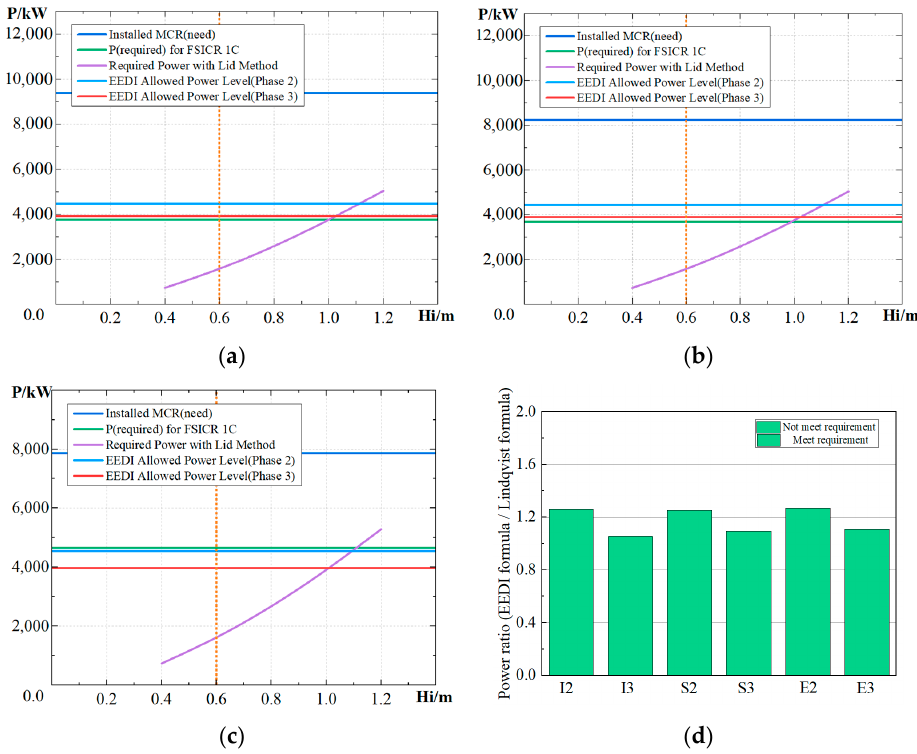
Figure 11. Power requirement results for 1C. ( a ) Power of traditional icebreaker bow, ( b ) Power of semi bow, ( c ) Power of EEDI type of bow form, ( d ) Power requirement comparison.